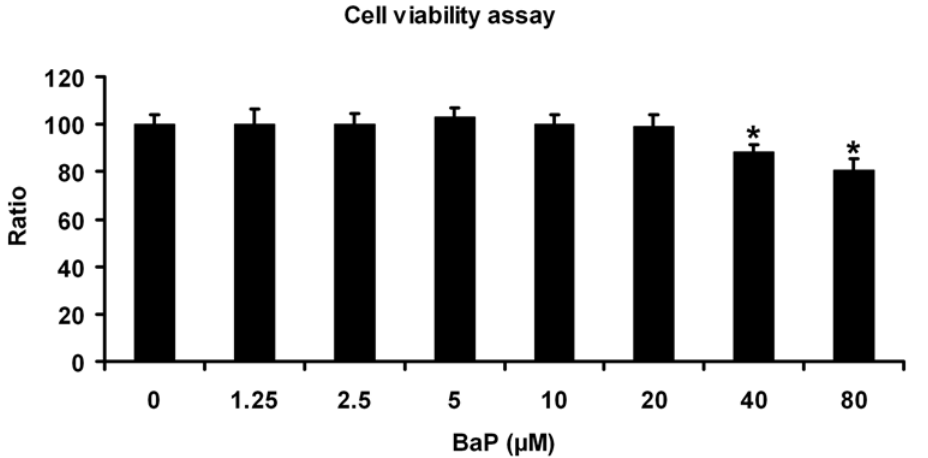
Figure 1. Cell viability assay for ARPE-19 cells treated with B(a)P. Concentrations in the media of 1.25 to 20 m M of B(a)P did not cause a significant decrease of cell viability (p . 0.05, n=10). Data are expressed as normalized ratios (Control=100).